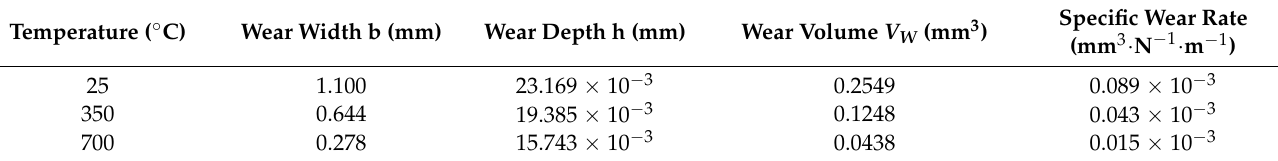
Table 6. The wear width, depth, volume, and specific wear rate of Ti-6Al-4V alloy at different temperature. Temperature ( ◦ C)